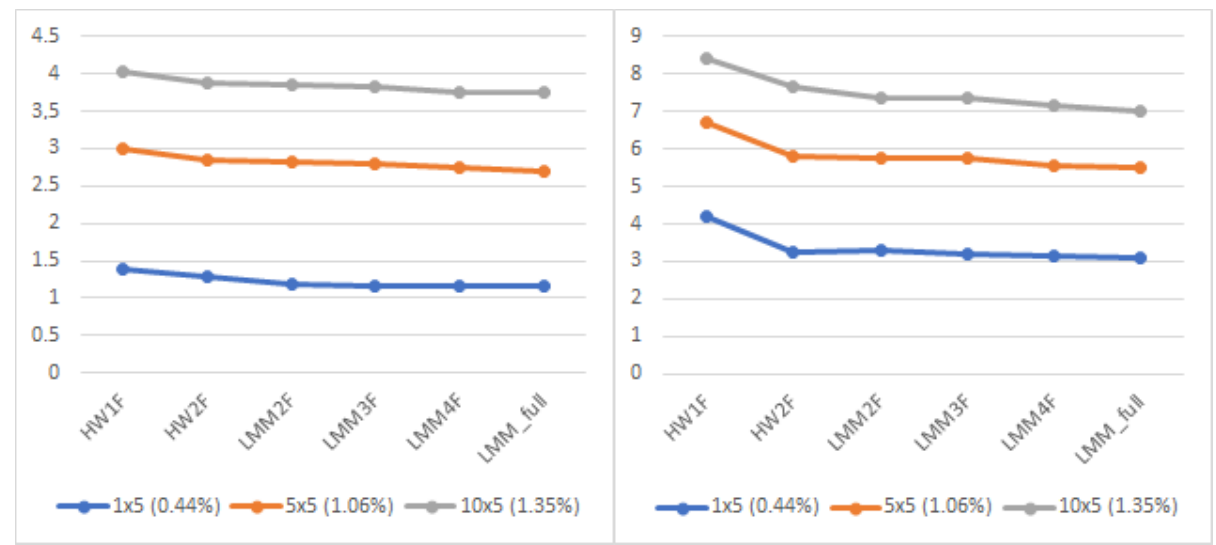
Figure 5. Factor dependence: prices of Bermudan swaptions on 5Y ( left-hand panel) and 10Y swaps ( right-hand panel) with time to first exercise set at 1, 5 and 10 years calculated using single- and multi-factor models calibrated to USD market data as of 11 September 2020 (in percent).